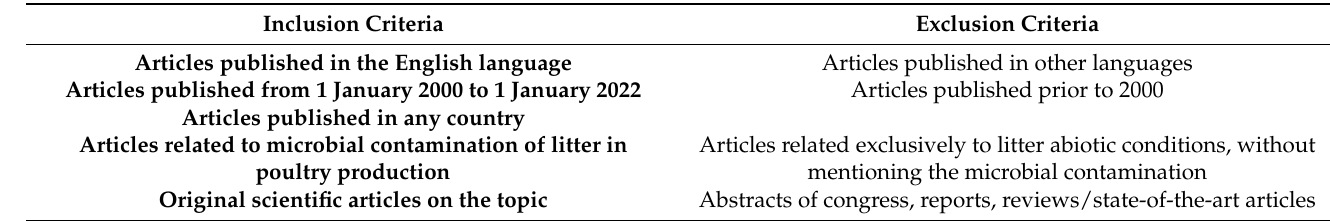
Table 1. Inclusion and exclusion criteria in the articles